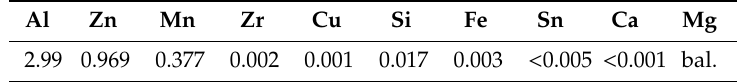
Table 1. Nominal chemical composition of the investigated AZ31 magnesium sheet